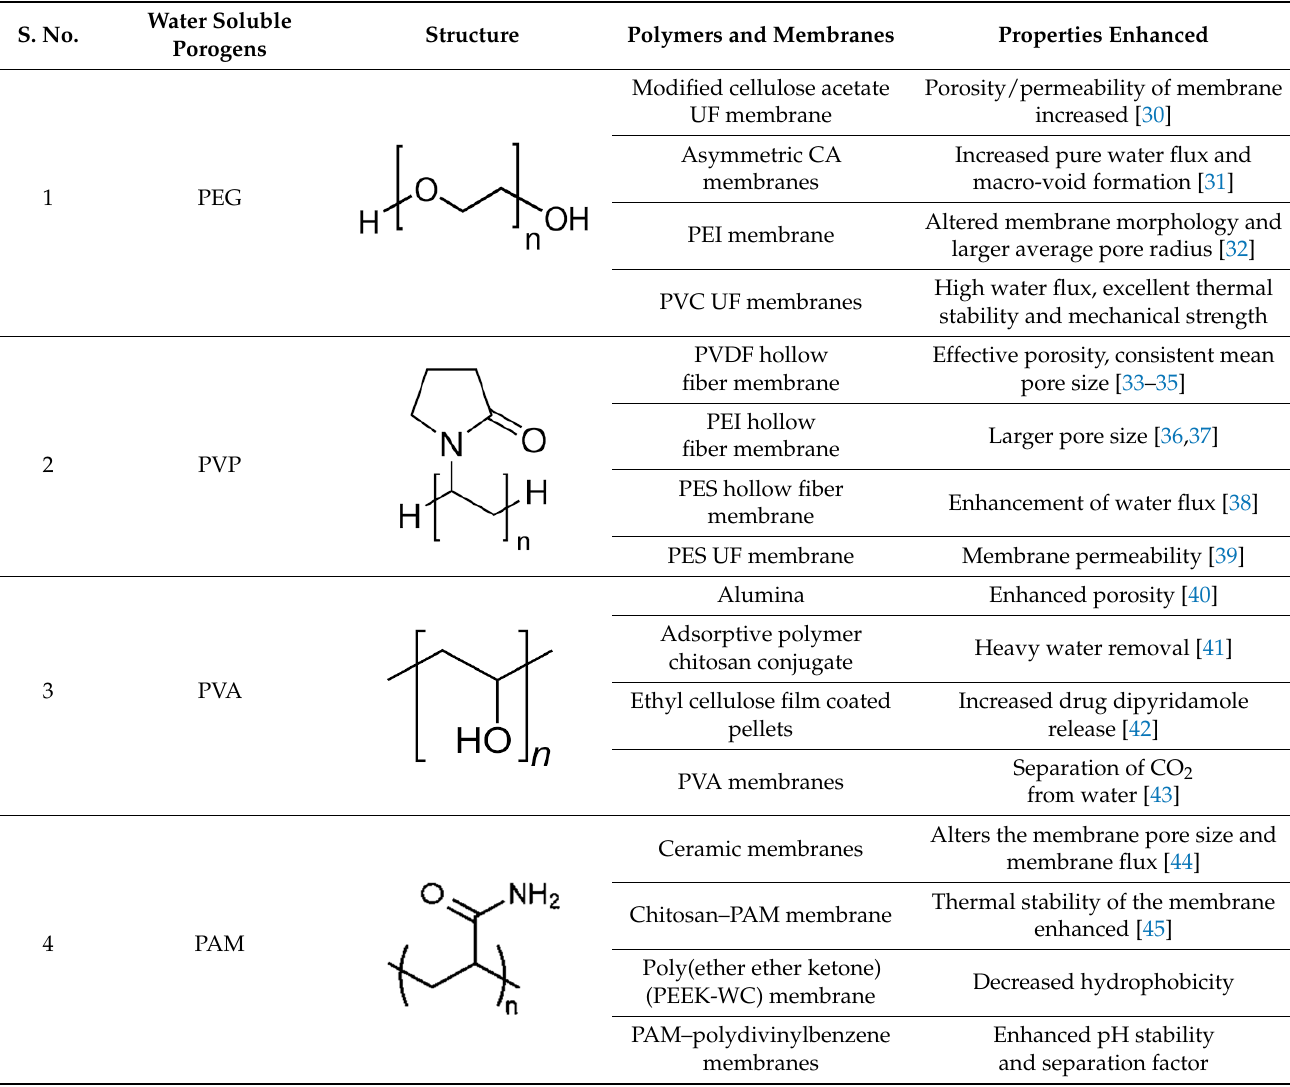
Table 4. Different water-soluble porogens used in ultrafiltration (UF)